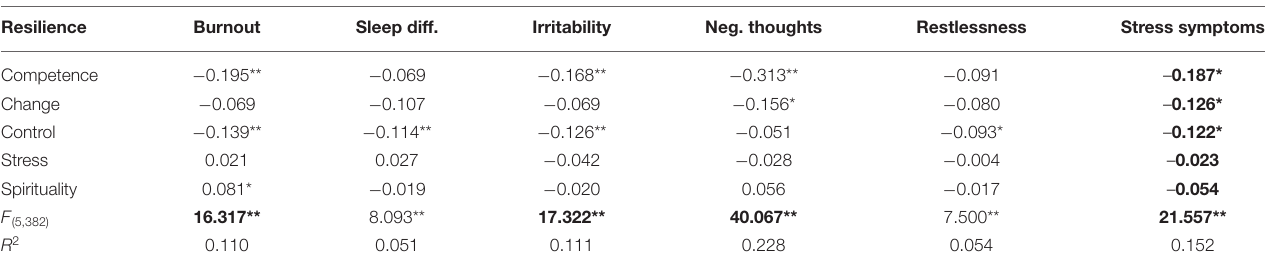
TABLE 6 | Multiple regression between factor of stress, and symptoms of academic stress ( n = 405). Resilience Burnout Sleep diff. Irritability Neg. thoughts Restlessness Stress